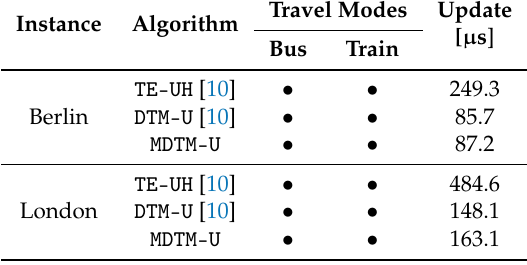
Table 8. Comparison among update algorithms for the TE-red, DTM, and MDTM models. Travel Instance Algorithm